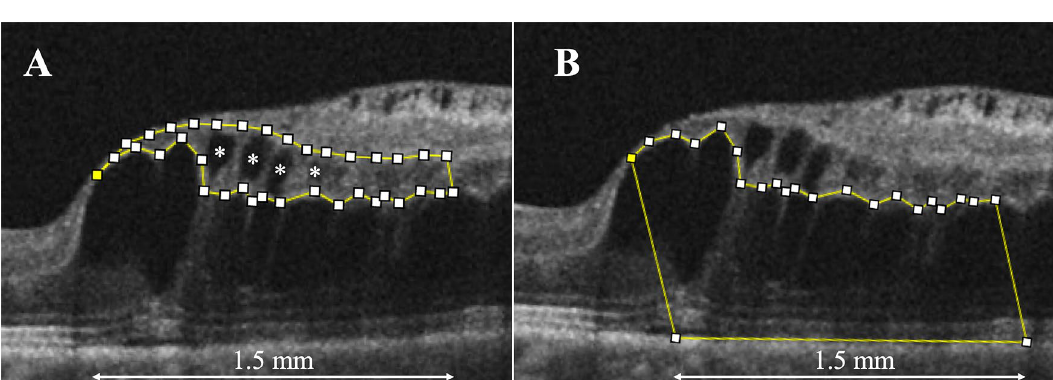
Figure 6. Assessment of the inner nuclear layer (INL) area, the number of INL cystoid spaces, and the outer retina area associated with branch retinal vein occlusion. ( A ) The INL area (between the inner and outer borders of the INL) was manually outlined within the affected 1.5-mm vertical optical coherence tomography (OCT) line from the fovea. The INL area is 0.263 mm 2 in this case. The number of INL cystoid spaces (asterisks) also was counted on this image. ( B ) The outer retina area (between the inner aspect of the outer plexiform layer and the inner border of the retinal pigment epithelium) was manually outlined and is 1.027 mm 2 in this case. These OCT parameters were measured within the affected 1.5-mm vertical line from the fovea (double-headed arrow). Figure is created using ImageJ software version 1.53a (National Institutes of Health, Bethesda, Maryland, USA, available at https:// imagej. nih. gov/